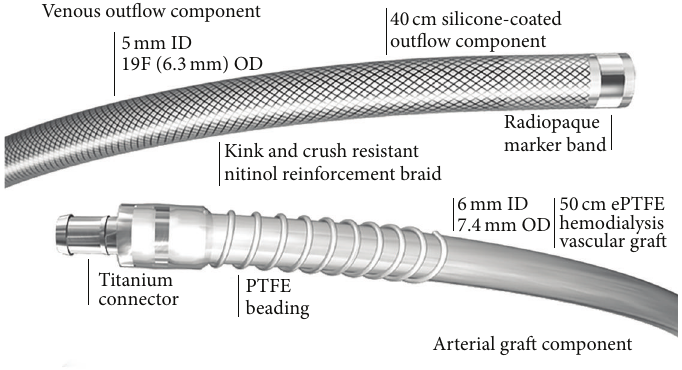
Figure 1: Used with the permission of CryoLife, Inc.